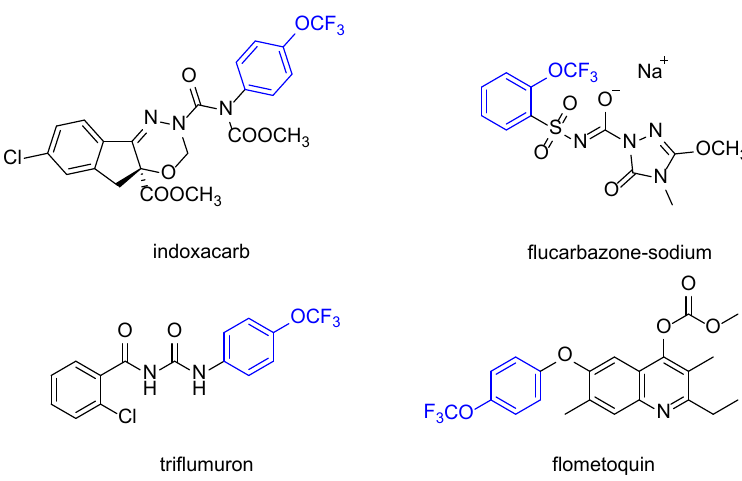
Figure 1. Reported α -trifluoroanisole structure-containing compounds. Protoporphyrinogen oxidase (PPO) is the last shared enzyme in the plant chlorophyll and animal heme biosynthesis pathways, which catalyzes the oxidation of protoporphyrinogen IX to protoporphyrin IX. Inhibiting the activity of PPO will lead to the massive accumulation of protoporphyrinogen IX, which penetrates the cytoplasm and is oxidized to protoporphyrin IX via other non-enzymatic mechanisms or oxidases. Protoporphyrin